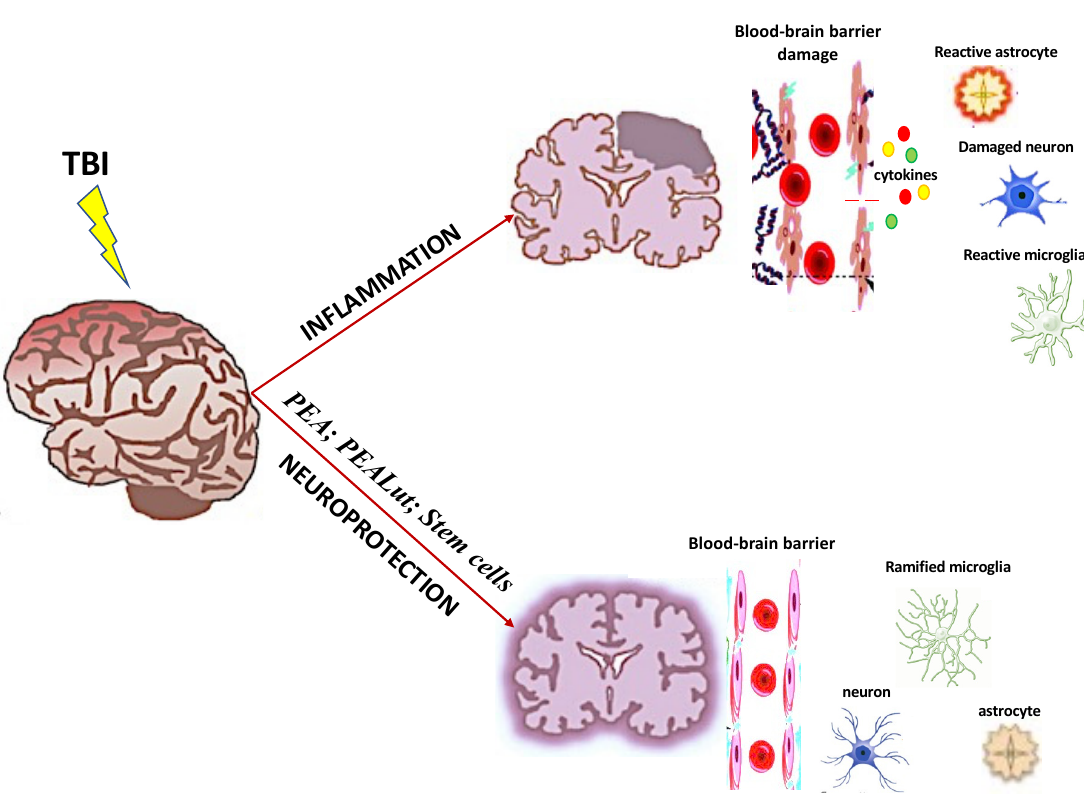
Figure 1. Pathophysiological heterogeneity detected in TBI.